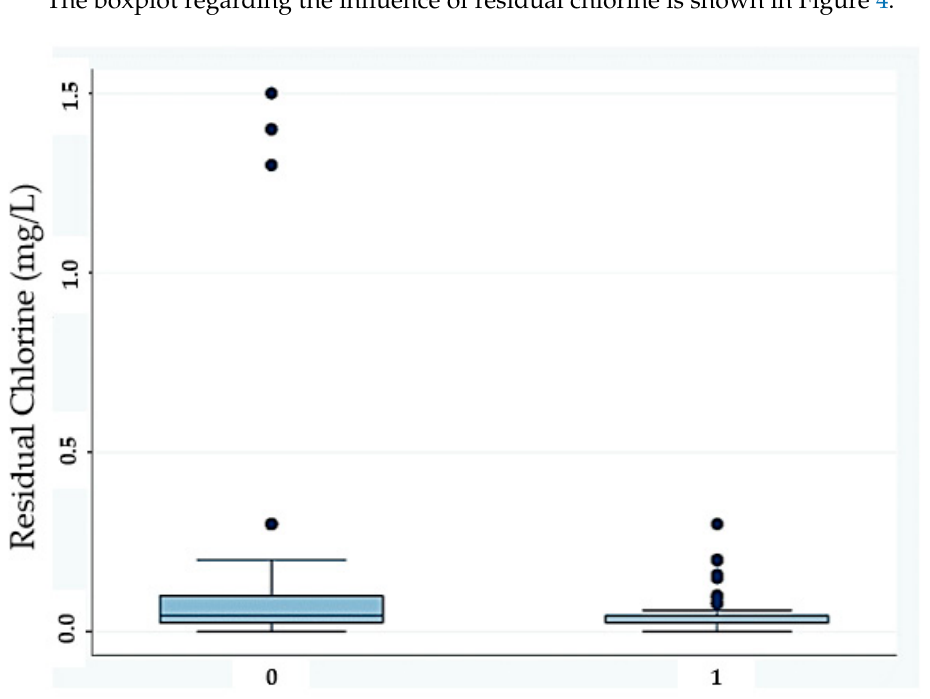
Table 5. Results of linear multiple regression.